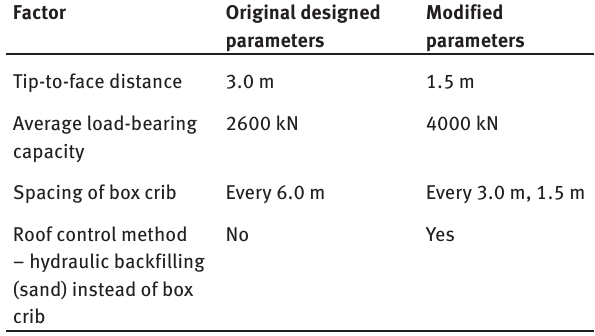
Table 6: Numerical calculation scenarios.